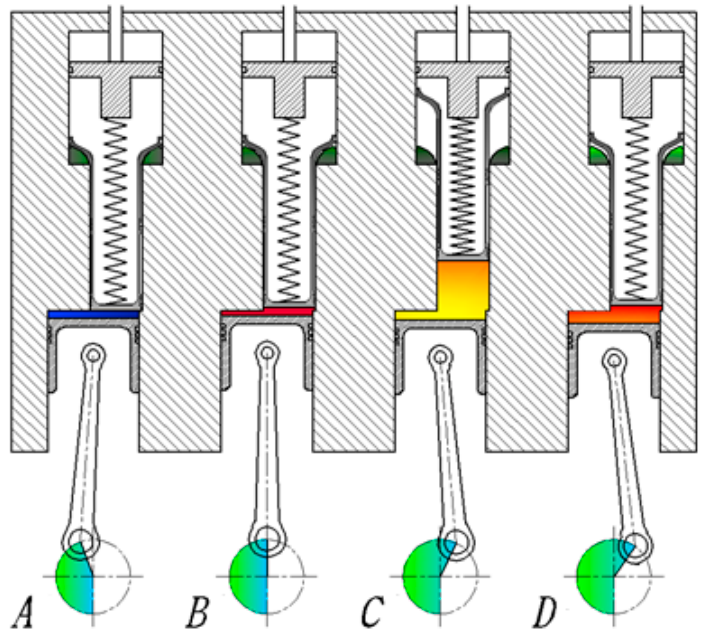
Figure 13. Real system ACC at key operating points.